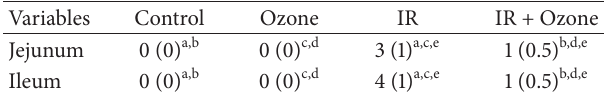
Table 2: The intestine injury scores for experimental groups.